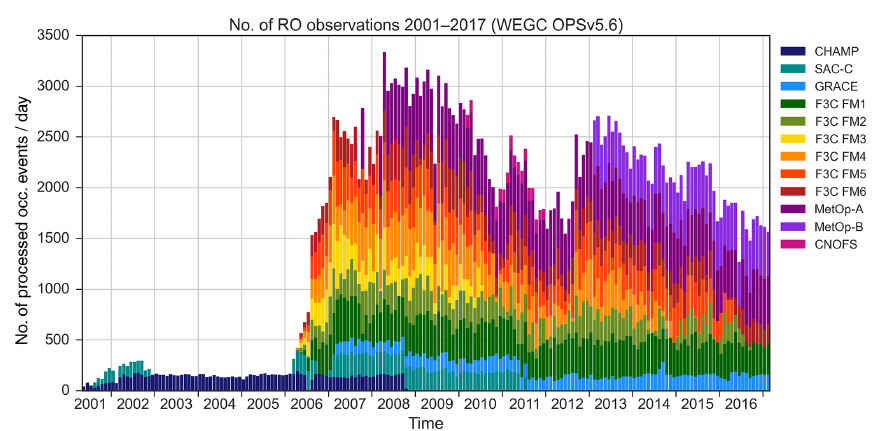
Figure 5. Daily number of high-quality OPSv5.6 profiles for different satellites (different colours) as a function of time from 2001 to 2017.